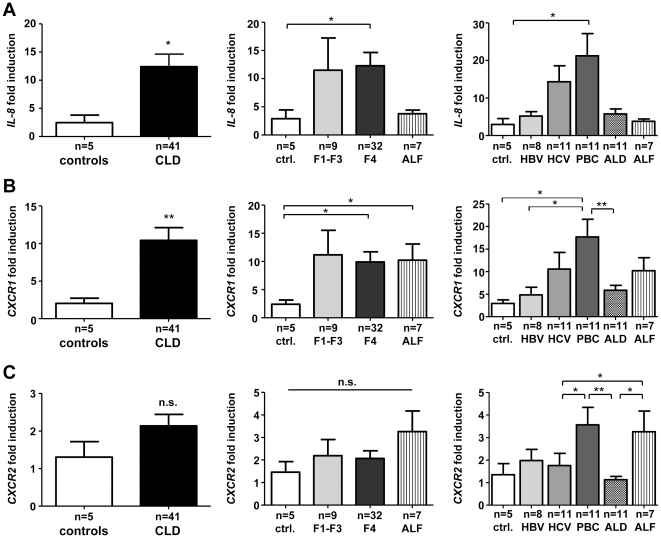
Intrahepatic IL-8 and IL-8 receptor gene expression.Gene expression levels of IL-8 (A) and the IL-8 receptors CXCR1 (B) and CXCR2 (C) were assessed from liver tissue by real-time qPCR and are displayed as fold induction. Samples from CLD patients were divided according to fibrosis stage (middle graphs) and to disease etiology (right graphs). Tissue from acute liver failure (ALF) was analyzed in parallel for comparison. CLD, chronic liver disease; ctrl, control; PBC, primary biliary cirrhosis; ALD, alcoholic liver disease; ALF, acute liver failure.